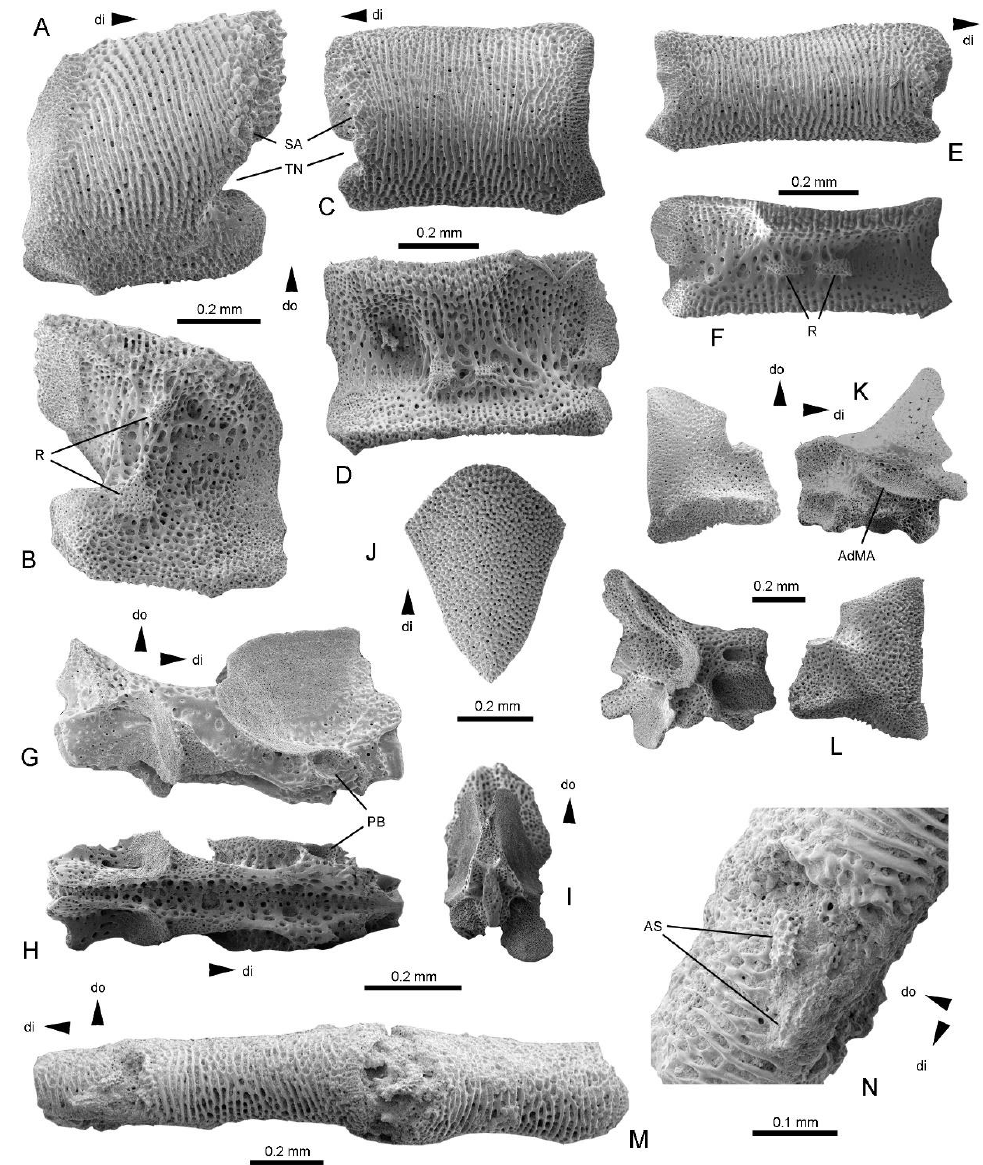
Figure 3. Ophiura tankardi sp. nov. from the Rupelian, Oligocene (Rosenheim Subformation, Bodenheim Formation, nannoplankton zone NP 24 and to dinoflagellate zones D 14/D 15) of a flush drill made at Nierstein, Rhineland-Palatinate, Germany. Holotype (NHMMZ PWL 2022/5560.1-LS), dissociated proximal lateral arm plate in external ( A ) and internal ( B ) views; paratype (NHMMZ PWL 2022/5560.2-LS), dissociated median lateral arm plate in external ( C ) and internal ( D ) views; paratype (NHMMZ PWL 2022/5560.3-LS), dissociated distal lateral arm plate in external ( E ) and internal ( F ) views; paratype (NHMMZ PWL 2022/5560.4-LS), dissociated proximal vertebra in lateral ( G ), ventral ( H ) and distal ( I ) views; paratype (NHMMZ PWL 2022/5560.5-LS), dissociated proximal dorsal arm plate ( J ) in external view; paratype (NHMMZ PWL 2022/5560.6-LS), dissociated oral plate in adradial ( K ) and adradial ( L ) views; paratype (NHMMZ PWL 2022/5560.7-LS), distal arm fragment in lateral view ( M ) and with detail of arm spines ( N ). Abbreviations: AdMA: adradial muscle attachment area; AS: arm spine; di: distal; do: dorsal; PB: podial basin; R: vertebral articular ridge; SA: spine articulation; TN: tentacle notch. Diagnosis : Small species of Ophiura with fragile lateral arm plates of oblique trapezoidal outline, with a well-developed, fine vertical striation on the outer surface, three small